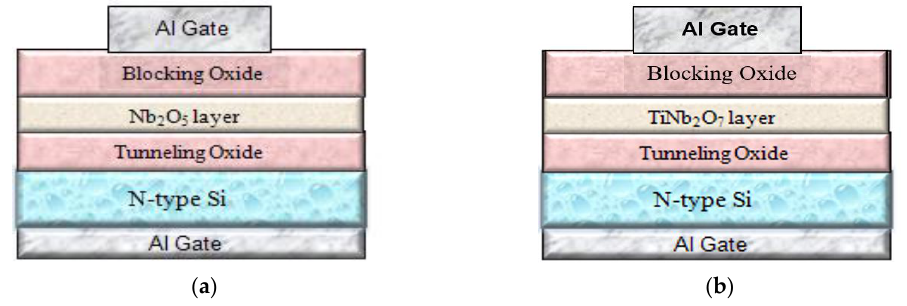
Figure 1. The schematic diagram of ( a ) Al/SiO 2 /Nb 2 O 5 /SiO 2 /Si MOHOS ( b ) Al/SiO 2 /TiNb 2 O 7 /SiO 2 /Si ( MOHOS) -type flash memory devices.